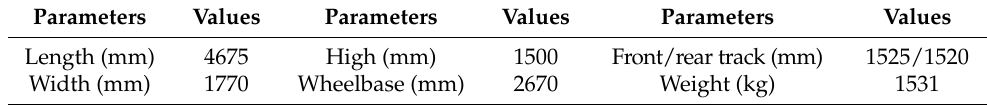
Figure 9. Force analysis diagram: ( a ) force analysis when NEV travels in a straight line; ( b ) force analysis of node j. Table 3. Basic parameters of NEVs.